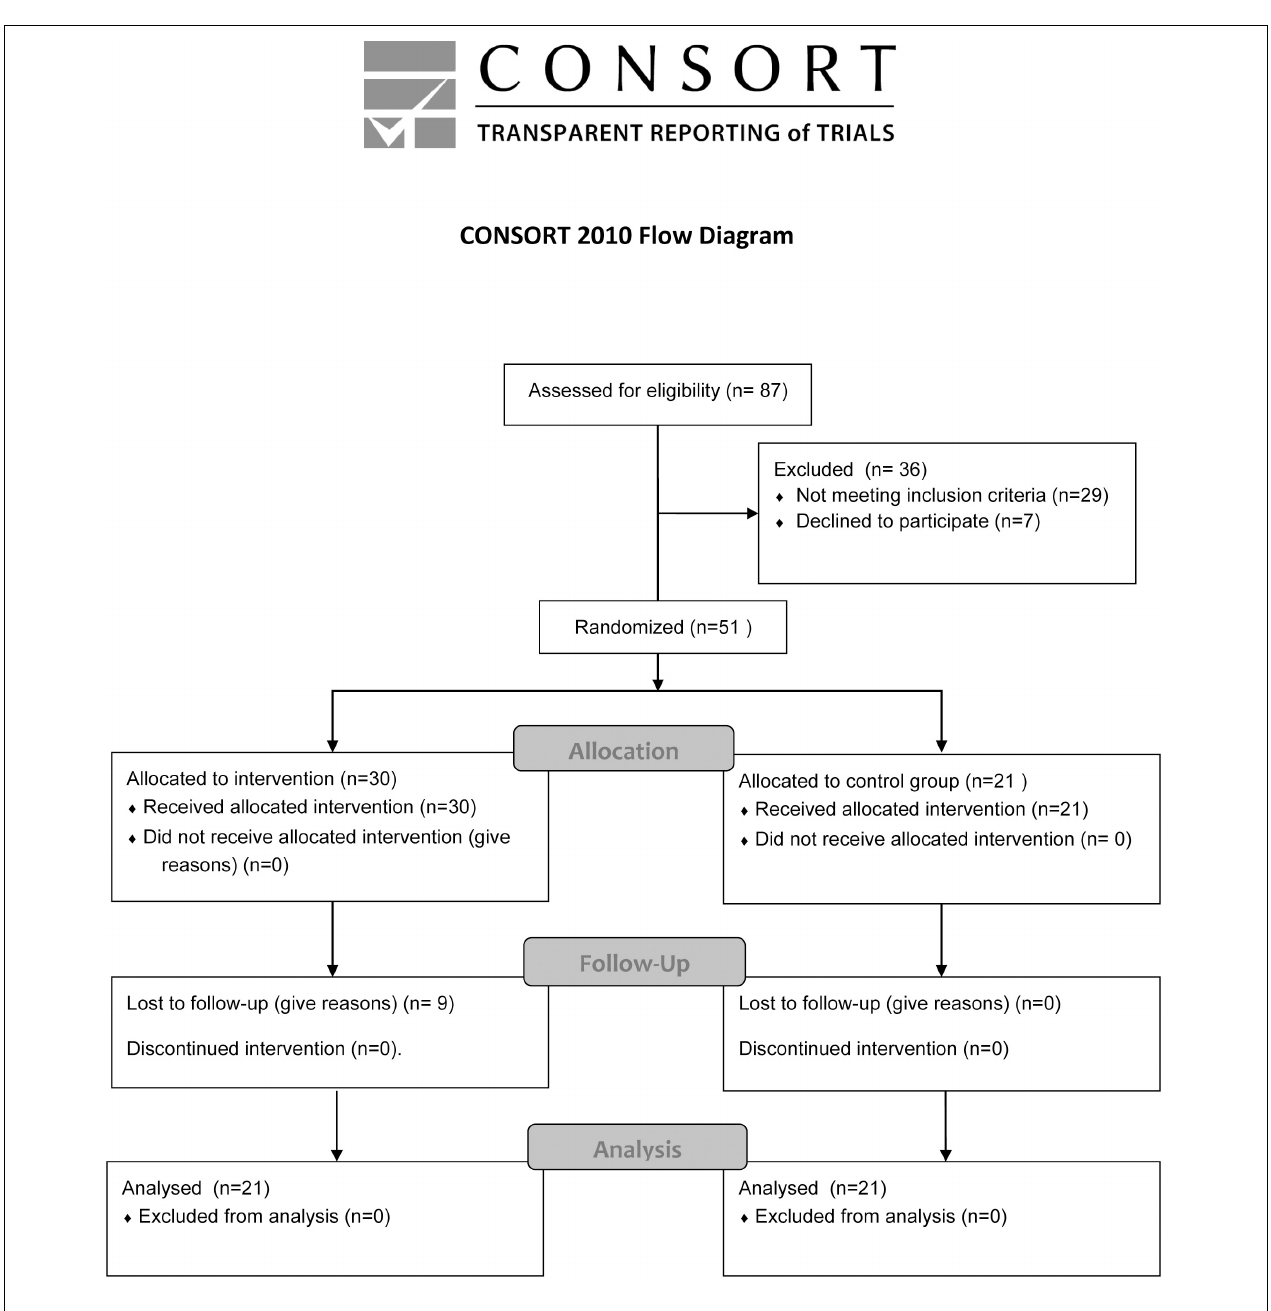
FIGURE 1 | Consort flow